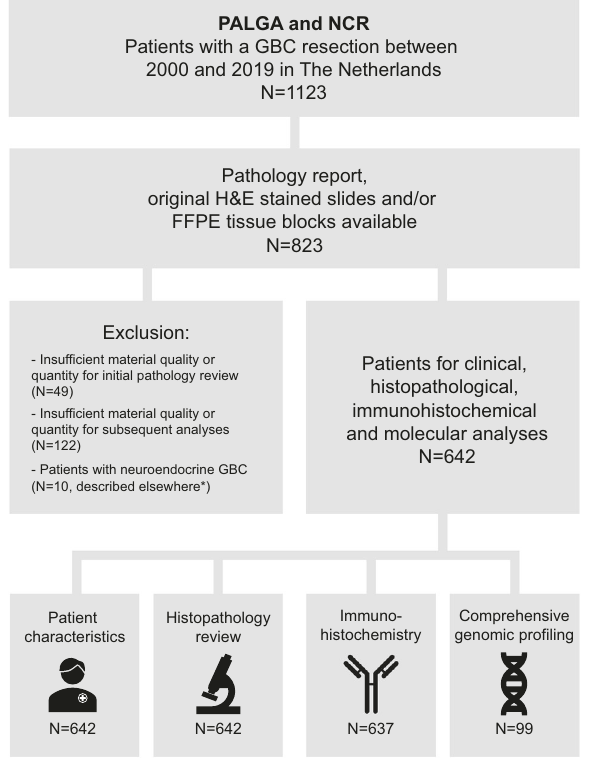
Fig. 1 Flowchart of the study. Patients were anonymously selected using PALGA and the NCR and their clinical, histopathological and molecular characteristics were analysed. PALGA Dutch Nationwide Pathology Databank, NCR Netherlands Cancer Registry, H&E hematoxylin and eosin, FFPE Formalin-Fixed Paraf fi n-Embedded. *Patients with neuro-endocrine GBC were described previously 21 .